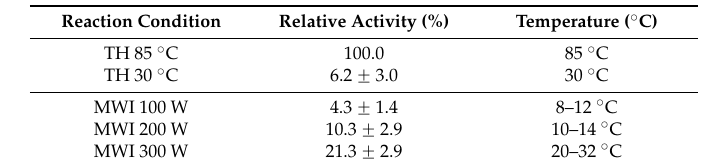
Table 2. Hydrolytic activity of recombinant β -glycosidase from Pyrococcus woesei strain DSM 3773 under fixed microwave irradiation energy (MWI) in comparison to conventional thermal heating (TH).